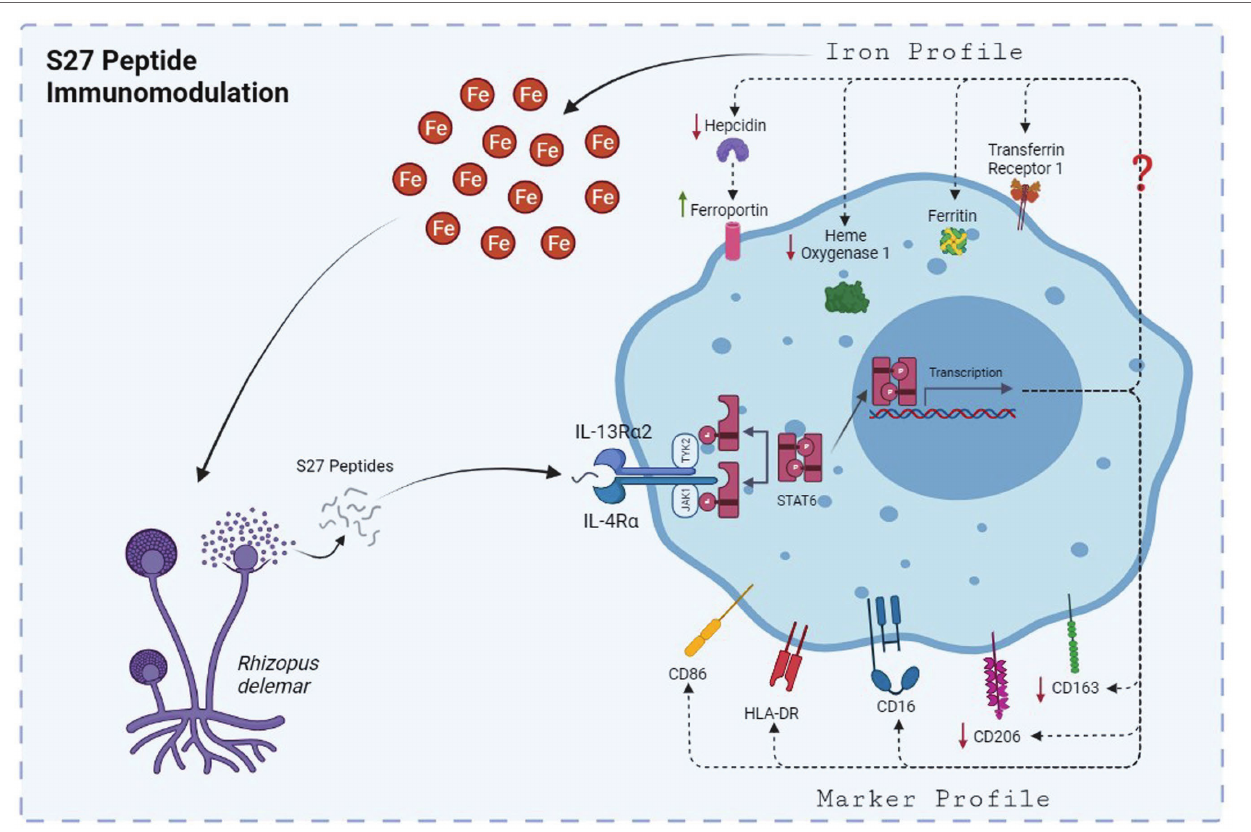
FIGURE 11 | The mechanism by which S27 peptide caused anti-inflammatory modulation to PBMMs. Upon dissemination, secreted S27 interact with IL-4/IL-13R complex causing and early phosphorylation of STAT6. Macrophages will polarize into M2-like phenotype and modulation in iron handling proteins that favors the release of iron into the milieu of mucormycosis that support further persistence and